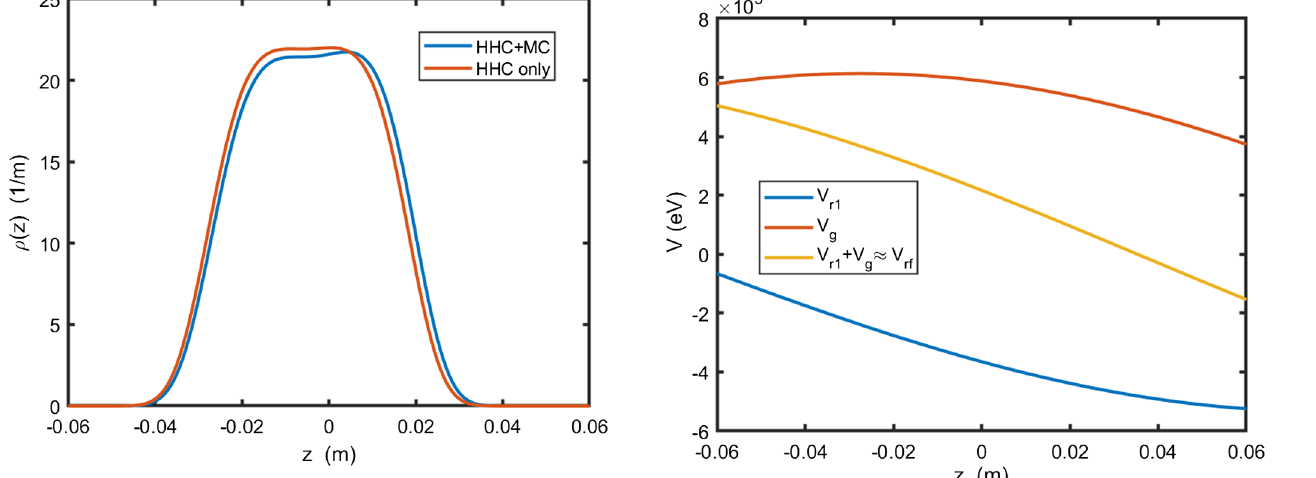
FIG. 3. Relative deviation of V